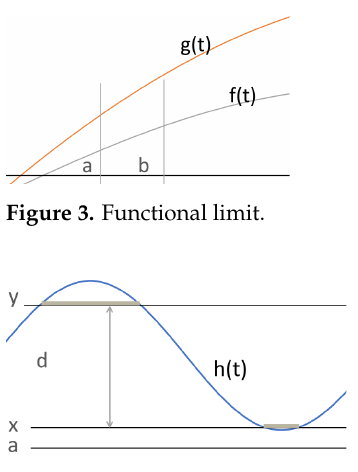
Figure 4. Constant limits and